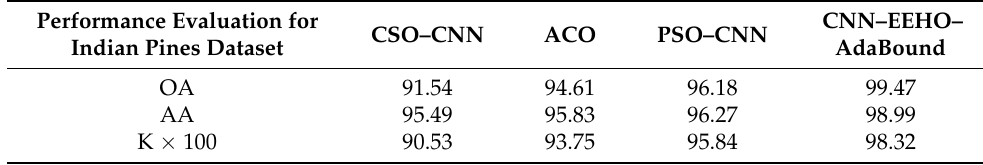
Table 6. Overall accuracy of Salinas dataset with other optimization algorithms .